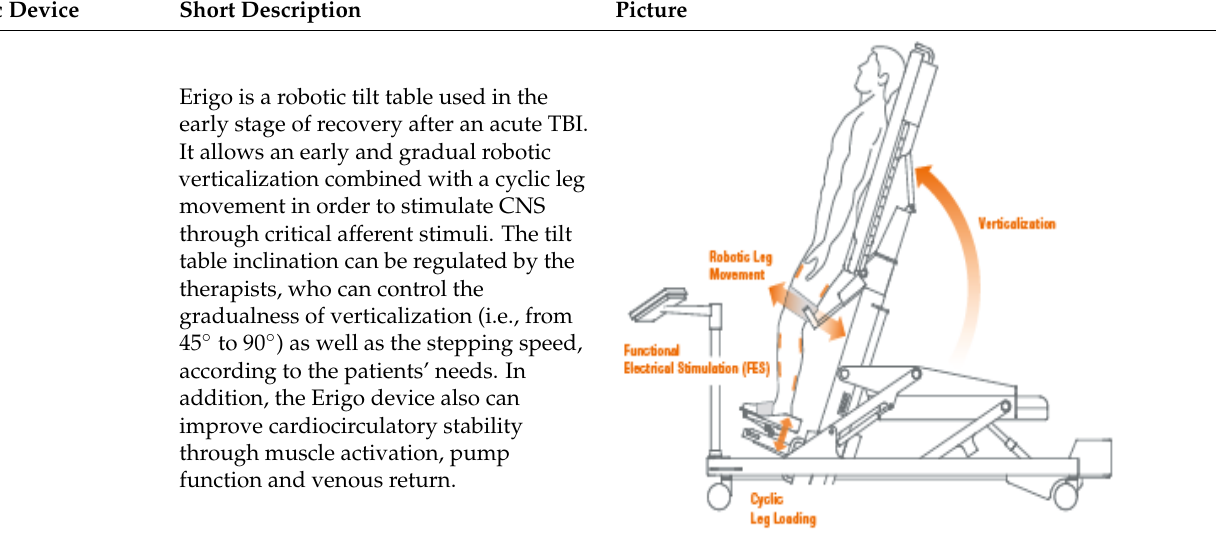
Table 2. Description of the main innovative neurorehabilitation tool used in TBI patients. Robotic Device Short Description